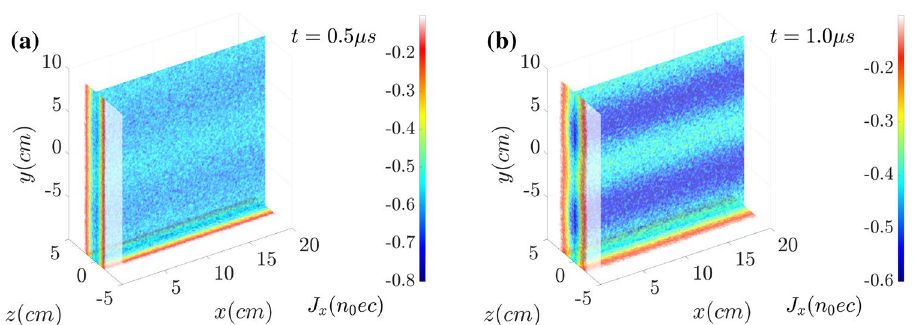
Figure 9. Distributions of current near the electron current sheet J x at ( a ) t = 0.5 µ s and ( b ) t = 1.0 µ s . By the wobbling or oscillating motion of the sheet electron current along y , the onsets of the filamentation and magnetic reconnection are delayed and mitigated